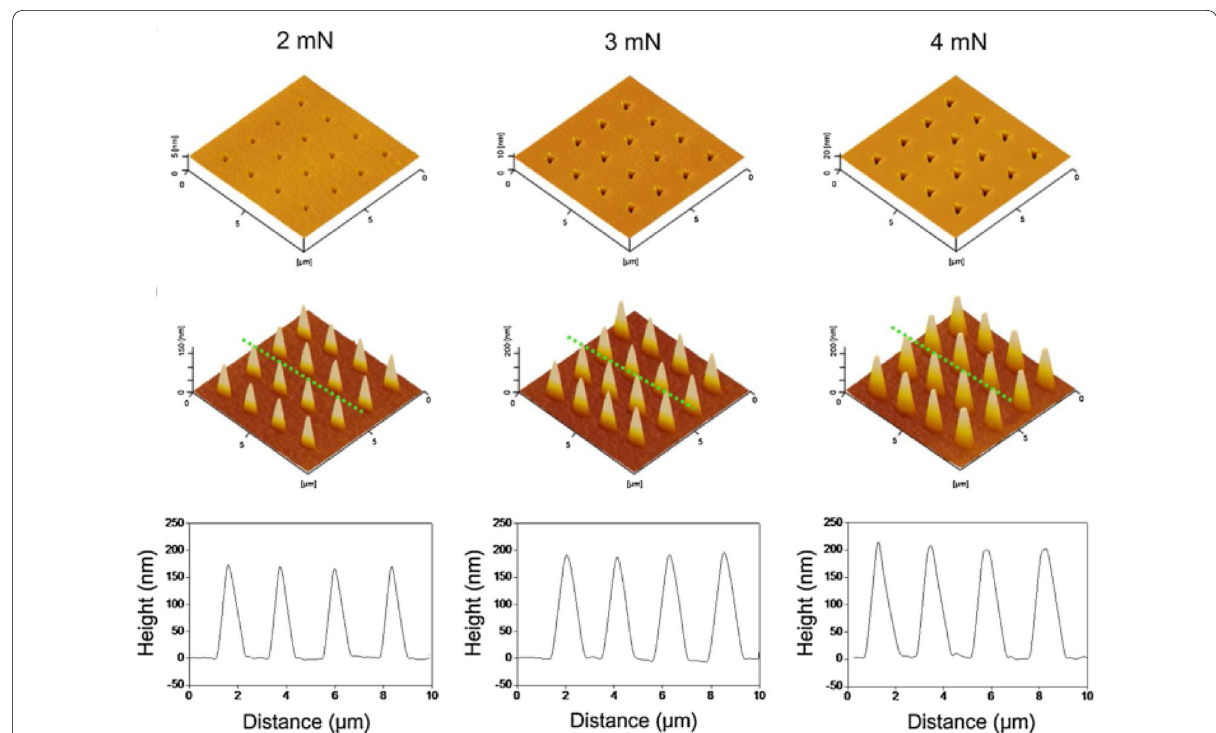
Figure 18 Fabrication of pyramid tip arrays by indentation-induced selective etching on silicon surface [72]: ( a ) & ( b ) AFM images of indented regions produced under 2, 3, and 4 m N before and after the etching in KOH solution for 10 min, ( c ) cross-sectional profiles of fabricated tips were · obtained from the dotted lines marked in ( b